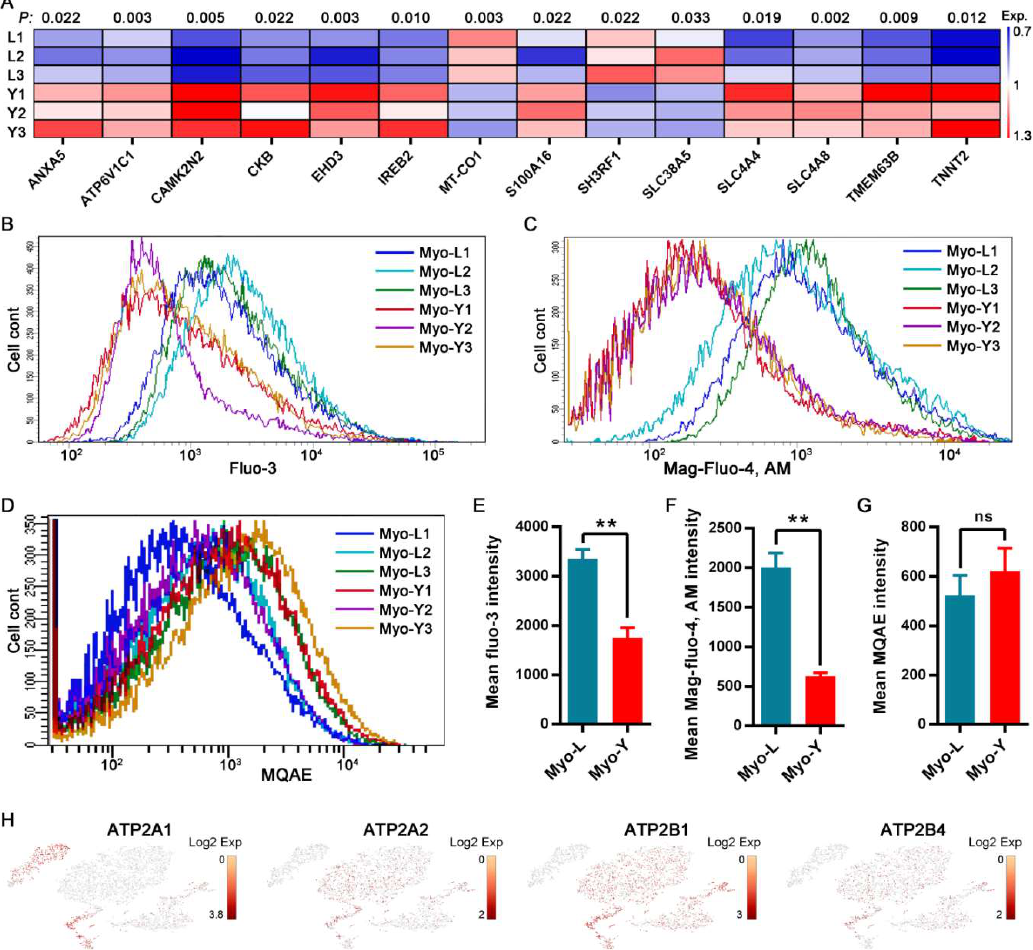
Figure 7. Ion concentration regulation of Myo-lineage cells between obese- and lean-type pigs. ( A ) The differentially expressed proteins involved in the regulation of cellular ion concentration. The scale showed the normalized relative protein expression. ( B , E ) The concentration of cytoplasmic Ca 2+ labeled by Fluo-3 ( n = 3). ( C , F ) The concentration of endoplasmic reticulum Ca 2+ labeled by mag-fluo-4, AM ( n = 3). ( D , G ) The concentration of cytoplasmic Cl − represented by the fluorescence of N -(ethoxycarbonylmethyl)-6-methoxyquinolinium bromide (MQAE) ( n = 3). ( H ) Individual gene tSNE plots showing the expression levels of Ca 2+ transports among Myo-lineage cells. * means p < 0.05, and ** means p < 0.01. Myo-L, Myo-lineage cells derived from skeletal muscle of obese-type pigs; Myo-Y, Myo-lineage cells derived from skeletal muscle of lean-type pigs.